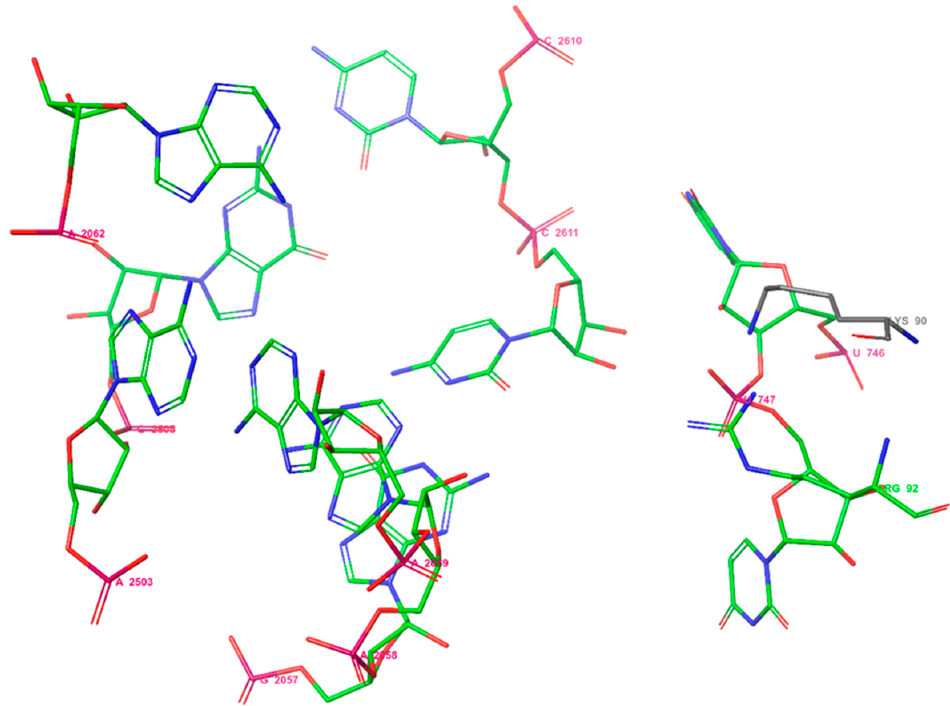
Figure 2. The binding site of erythromycin A in the E. coli ribosome. It was shown that the molecular docking into the narrow region around amino ac- ids Lys 90 and Arg 92 was possible only for 15-membered macrolides and 16-membered macrolides except for rosaramicin and tylosin A and B. The docking scores together with